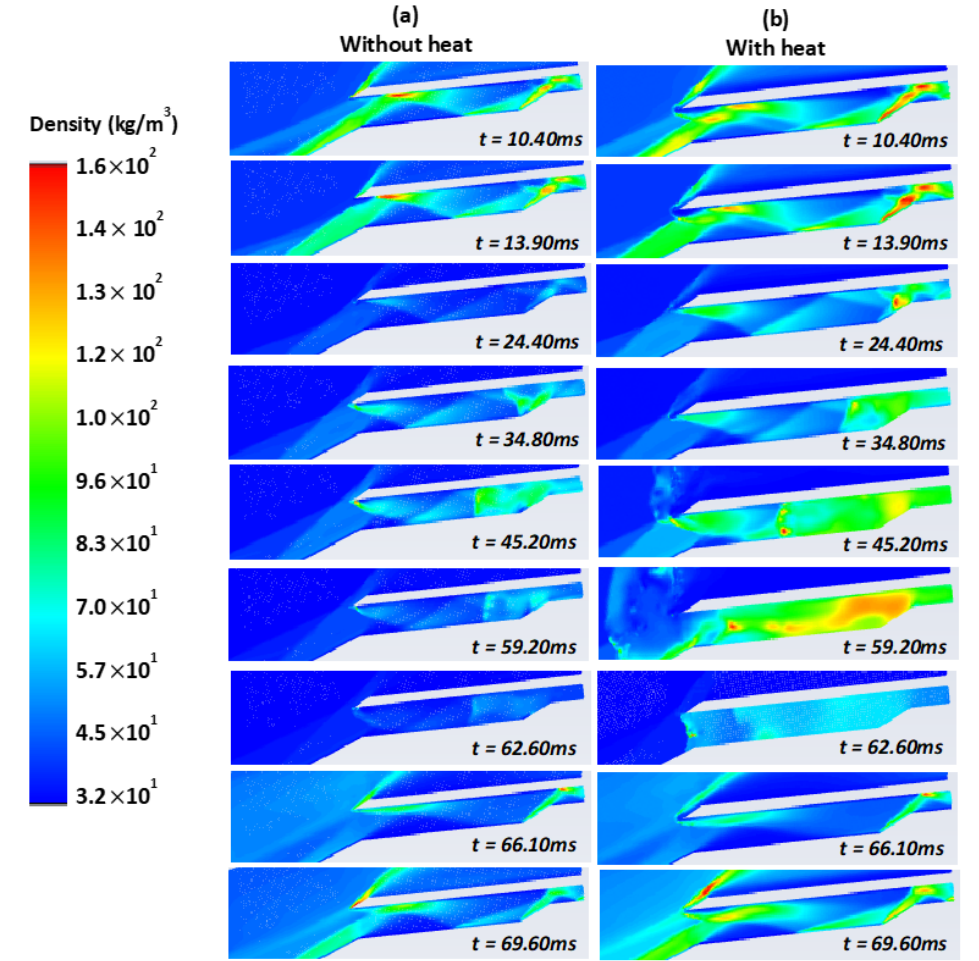
Figure 5. Density of AoA 6° and TR 0.5 ( a ) without and ( b ) with the heat of 1 mm 5 × 10 13 W/m 3 .